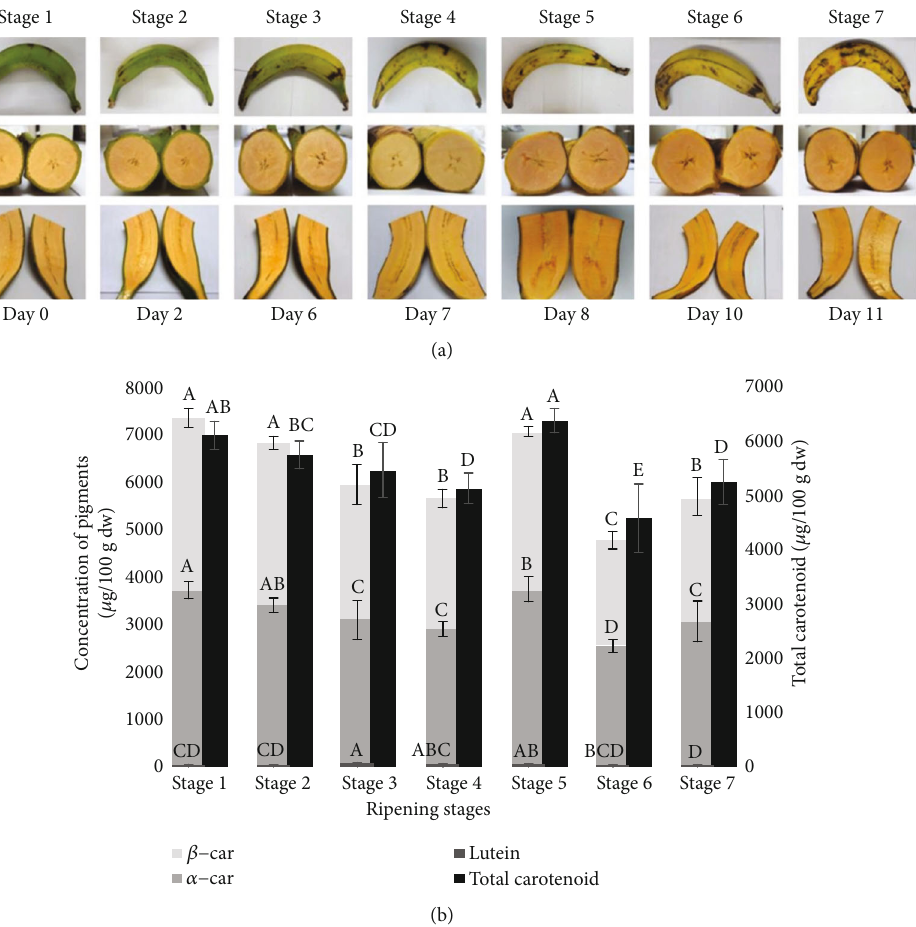
Figure 1: Changes in the carotenoids of Agung Semeru plantains during development. (a) Changes in the fruit colour during postharvest ripening. (b) Changes in the carotenoid content and composition of the fruit fl esh during postharvest ripening, obtained from analysis using HPLC ( β -car, α -car, and lutein) and spectrophotometry UV-Vis (total carotenoid). Di ff erent lowercase letters indicate signi fi cant di ff erences among the ripening stages ( p < 0 : 05